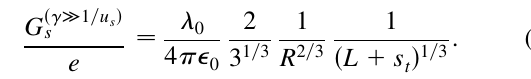
greatly overestimates the self-force (and hence the CSR) at (cid:23) (cid:1) 10 . For the same two (cid:23) values the unrenor- is exhibited for both curv- malized longitudinal force F s ing and straight strings in Fig. 12. Here the longitudinal range is extended both before and after the actual string. The vertical axis has been artificially distorted (cube root) in order to expand the dynamic range while leaving the internal force visible.